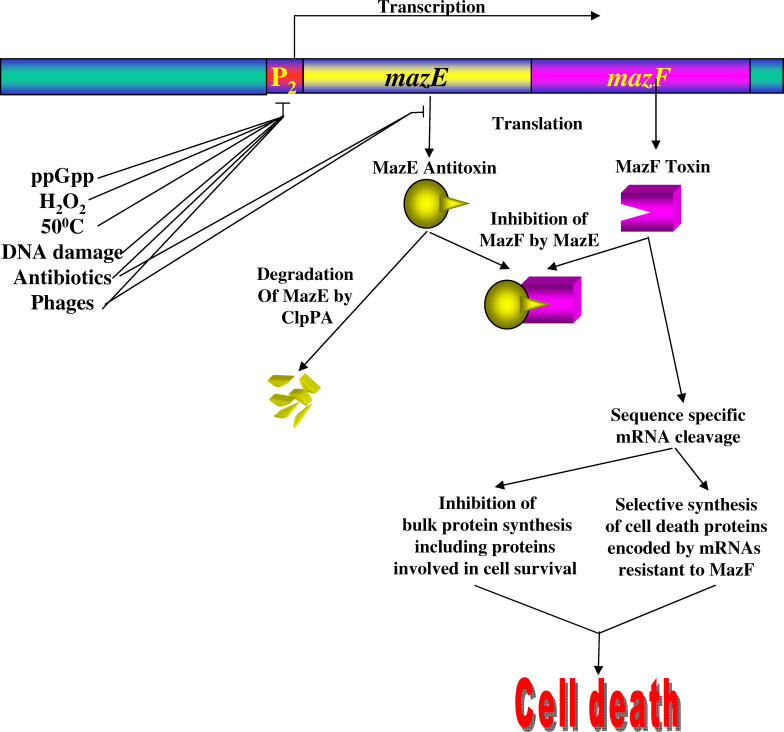
A Schematic Representation of E. coli mazEF-Mediated Cell DeathFor details, see the text.